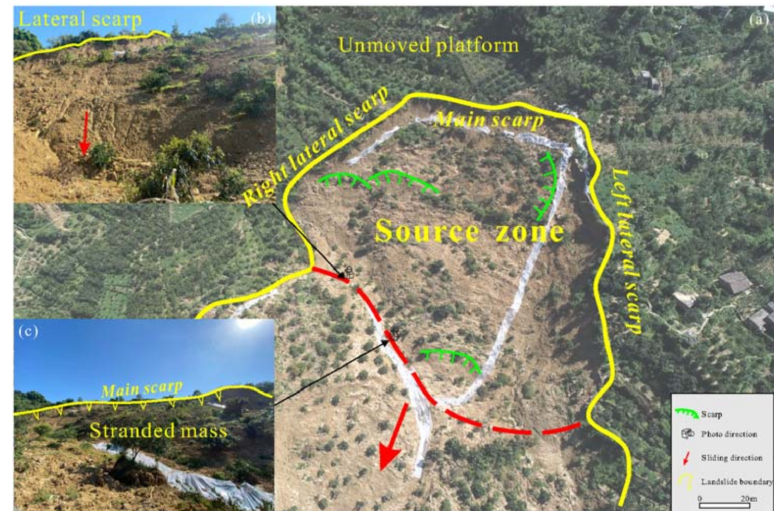
Figure 4. ( a ) Overall view of the source zone. After the landslide occurred, the main scarp formed at the rear edge, and the main slide direction of the landslide was 18 ◦ in the source zone. ( b ) Right lateral scarp. ( c ) Stranded sliding mass below the main scarp.